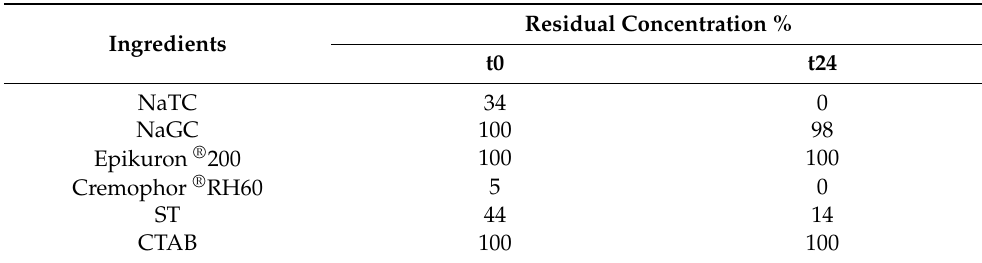
Table 3. H 2 S-DOXO stability at t0 and t24 in the presence of µ E ingredients, expressed as a residual concentration percentage.